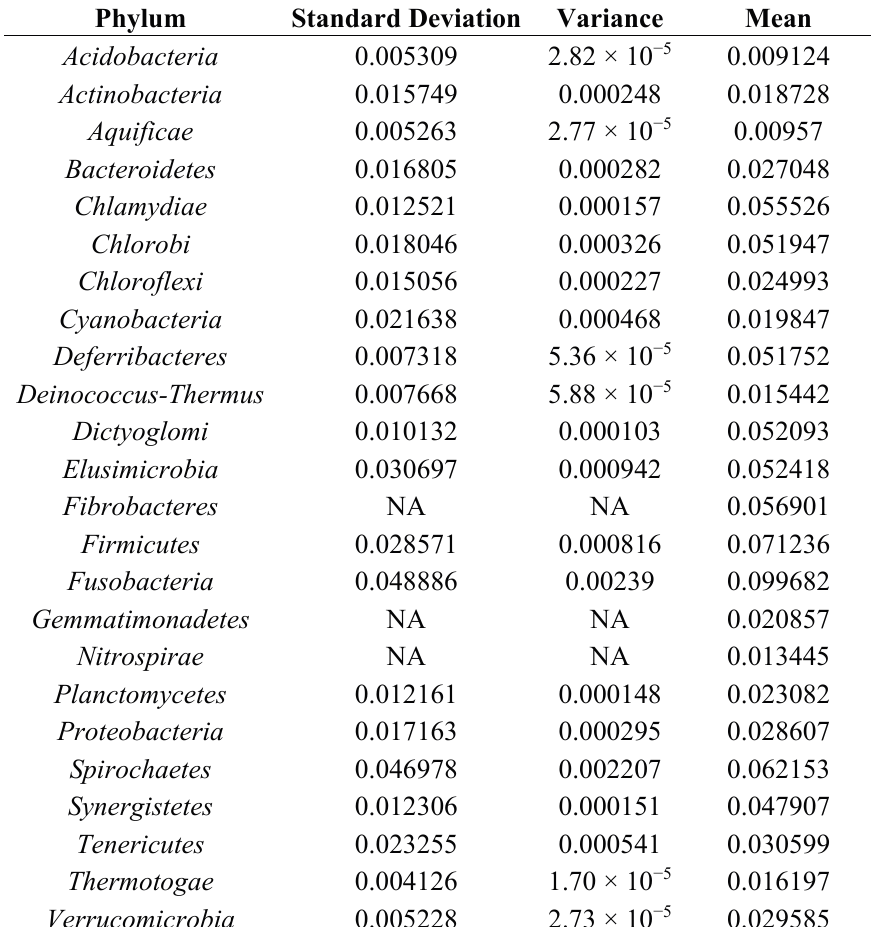
Table 1. Strand composition bias for each phylum a